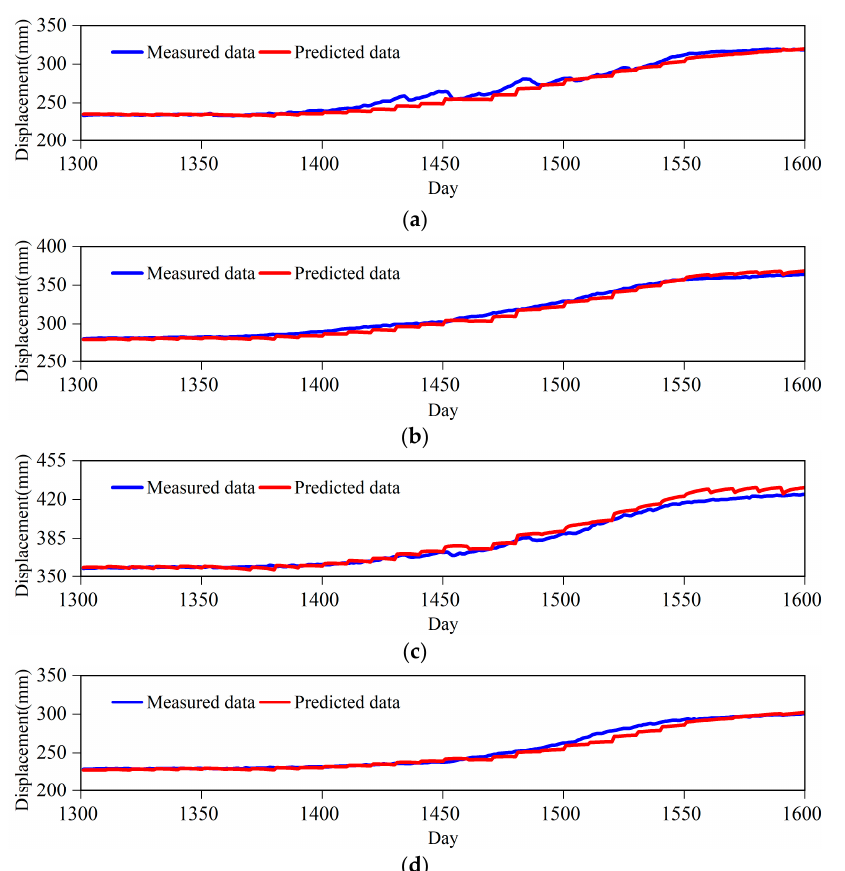
Figure 9. Prediction of displacement data (NM40%). ( a ) Point SZY-02; ( b ) point SZY-03; ( c ) point SZY-06; ( d ) point SZY-08. The blue curve represents the measured data and the red curve represents the predicted data.